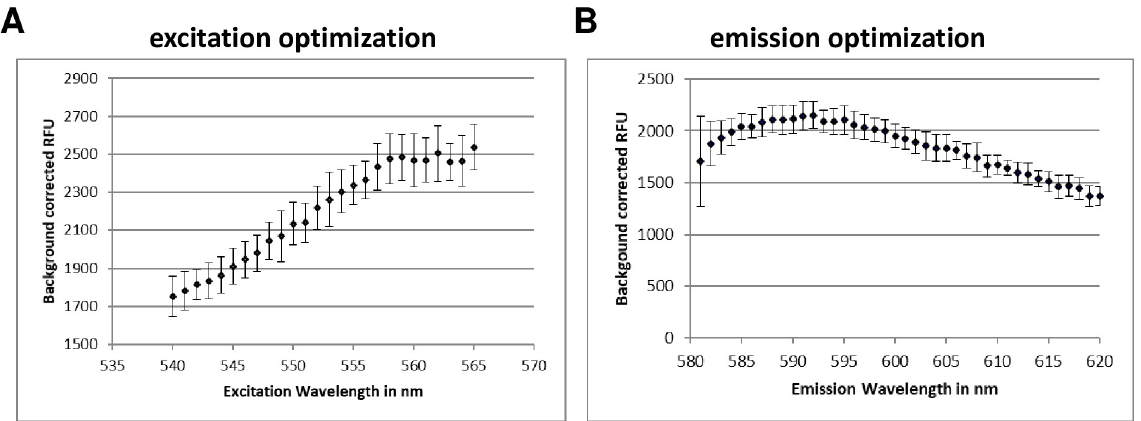
Fig 1. Optimization of fluorescence measurements. DREAM8 was dispensed into 384-well plates and fluorescence was measured at varying excitation wavelengths when the emission wavelength was fixed at 590nm (A) or at varying emission wavelengths when a fixed excitation of 558nm was used (B) . Data are the average ± SD from four wells.